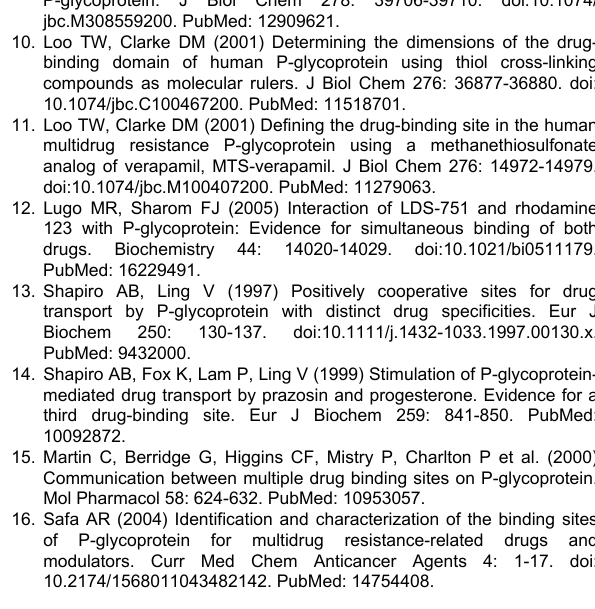
Table S3. Effect of cyclosporine A and tariquidar on verapamil-stimulated ATPase activity of mutant Pgps. Inhibition of verapamil-stimulated ATP hydrolysis by CsA